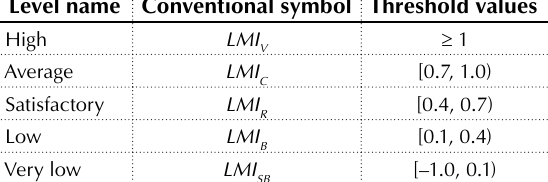
Table 2. Assessment of the socio-economic potential of health